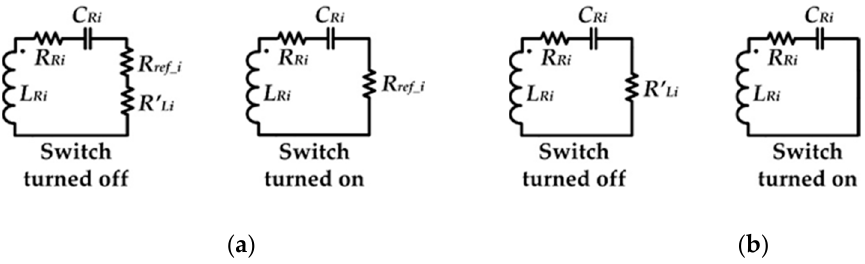
Figure 4. Switch turned off and on, equivalent circuit ( a ) of a repeater and ( b ) the last N th receiver ( b